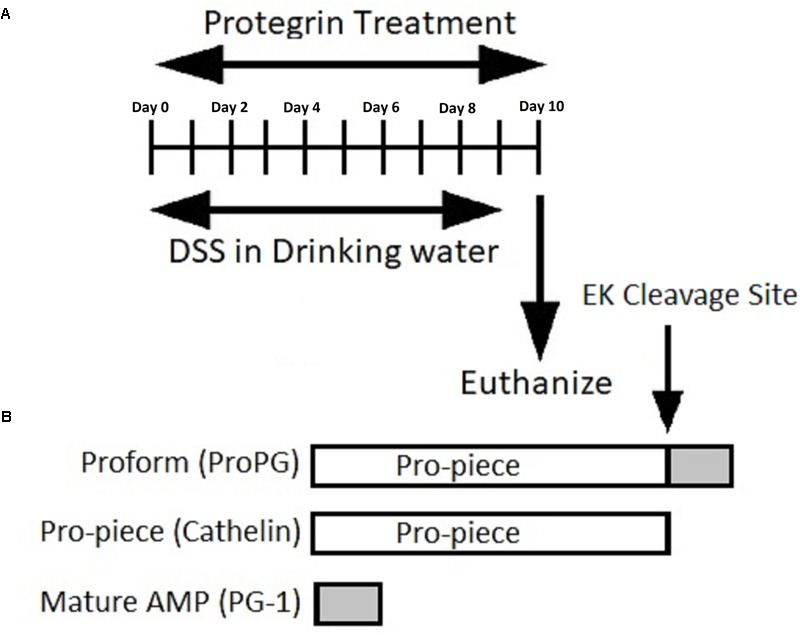
(A) Timeline representation of induction of colitis and protegrin treatment. (B) Schematic representation of the recombinant protegrin and its various forms: pro-, cathelin-, and mature-form PG-1.